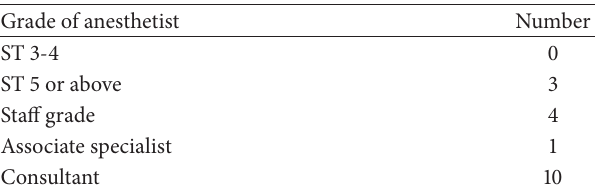
Table 1: Number of respondents by grade who had experienced a failed intubation for category 1 caesarean delivery without immedi- ate threat to parturient’s